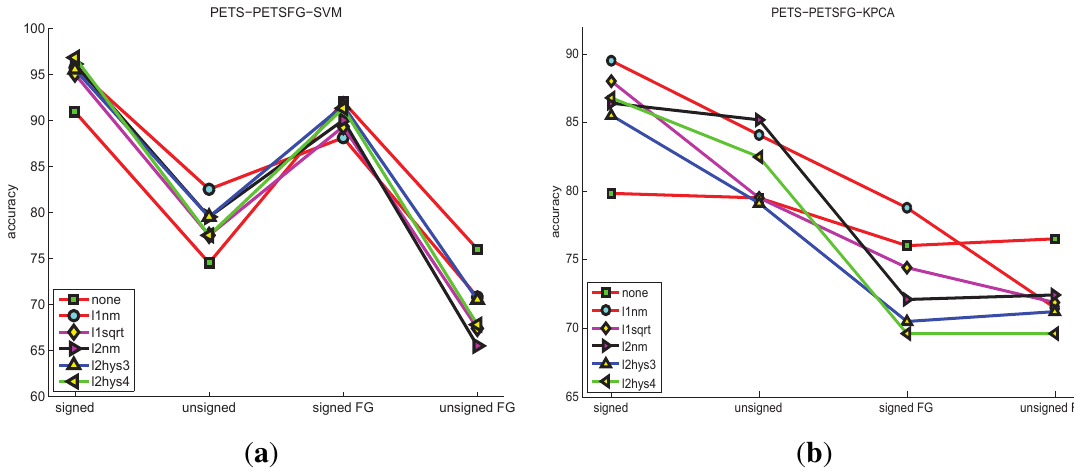
Figure 4. The accuracy of the PETS scene under different classification methods and different features: ( a ) HOFO descriptors are computed on the original and the foreground image, and one-class SVM is taken as the classification method, the maximum accuracy is 96 . 8% ; ( b ) HOFO descriptors are computed on the original image and the foreground image, and KPCA is taken as the classification method, the maximum accuracy is 89 . 5%